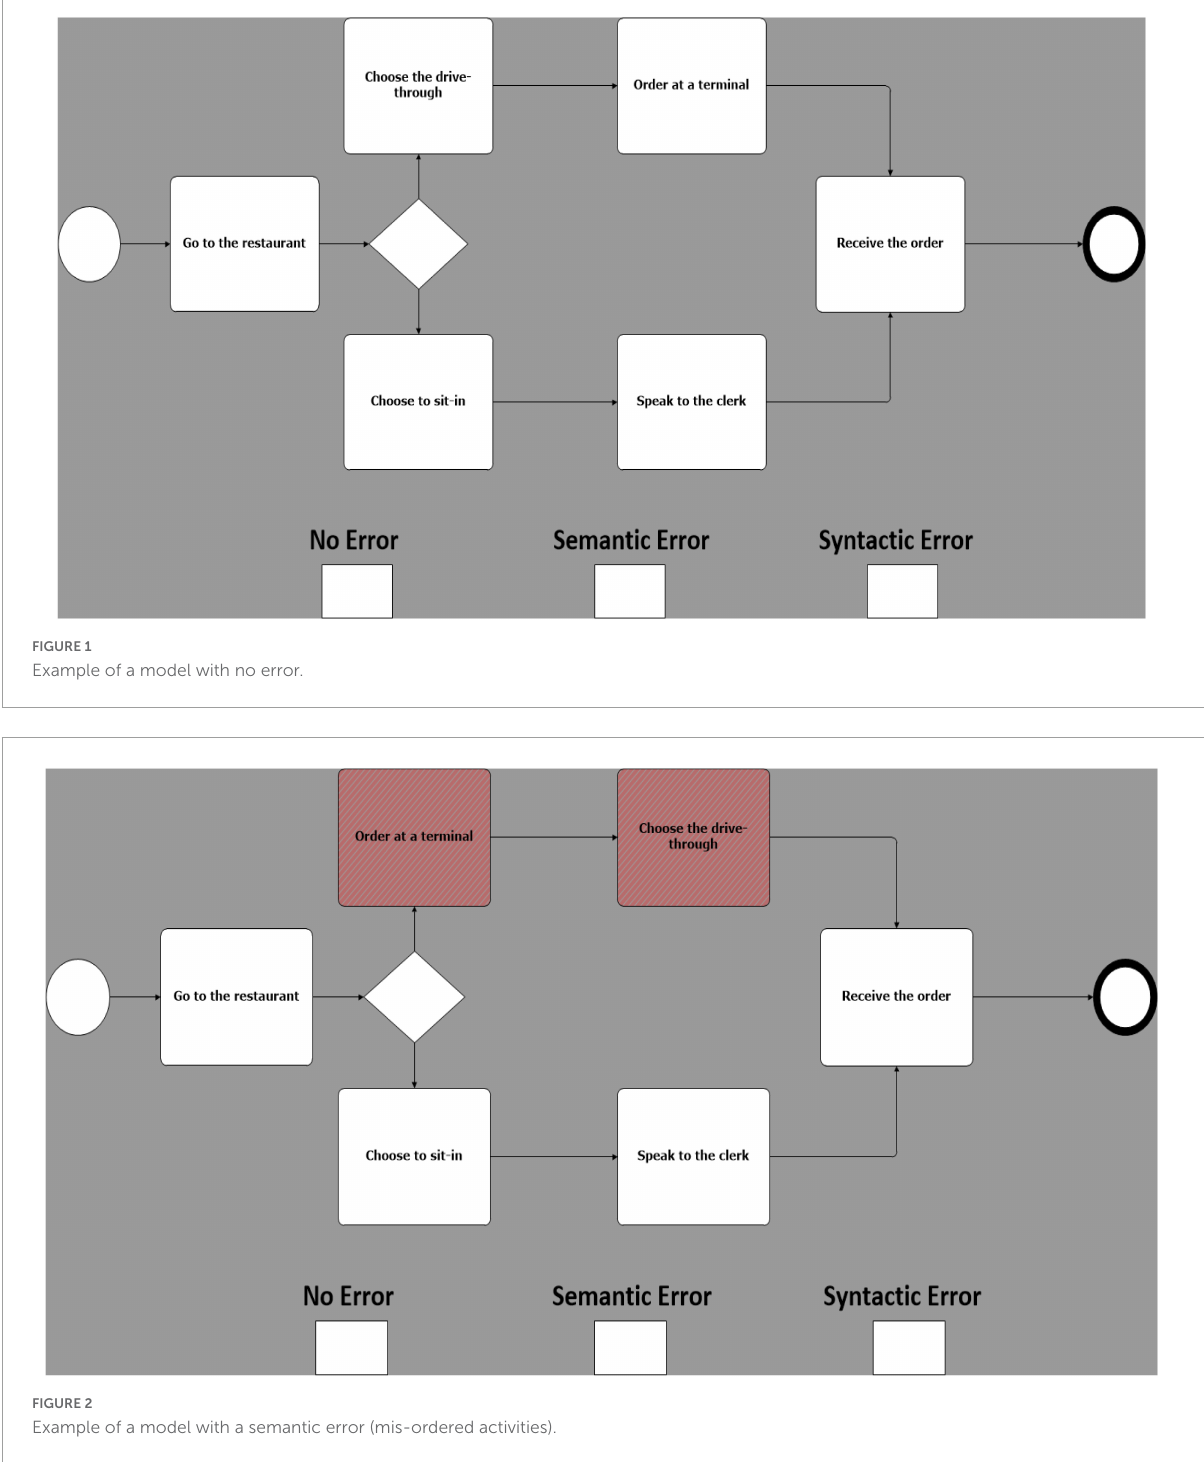
The task was composed of three (3) models, where each one had a different type of error (i.e., no error, semantic error, and syntactic error). To avoid any form of bias, the practice models were not related to the scenarios used later in the experiment